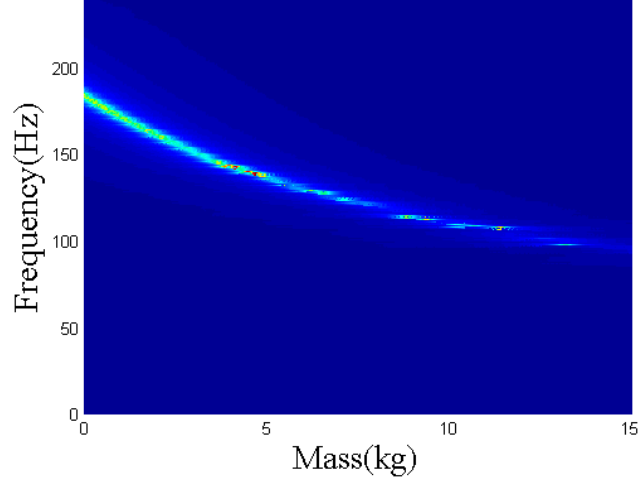
Figure 7. Nephogram of frequency response with respect to virtual mass.